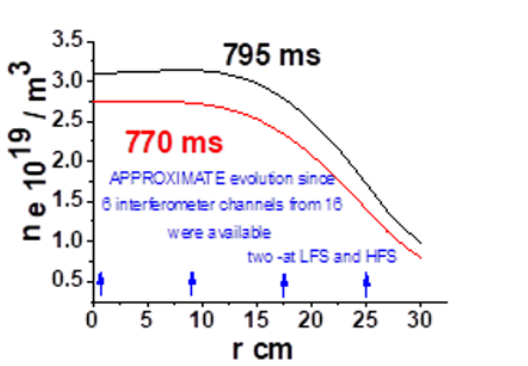
Fig. 6. Density profiles before and 20 ms after L-H transition.